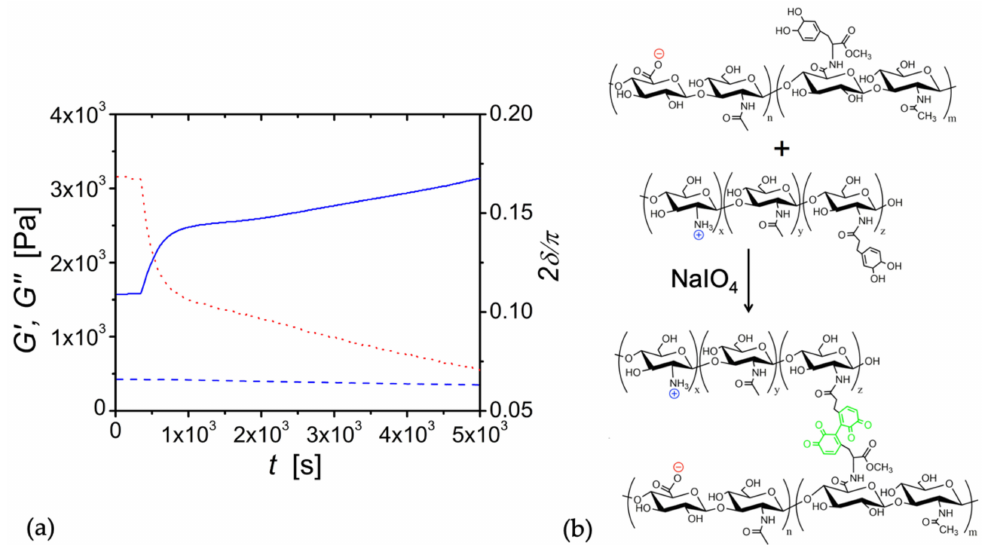
Figure 7. ( a ) Time sweep of CHI (F A : 0.42, catechol: 1 mol %)/HA (M w : 750 kDa, catechol: 1 mol %) coacervate, to which 1 mM periodate solution was added at the sample rim after 5 min. Frequency = 10 Hz. Strain = 2%. The blue solid line represents G (cid:48) , while the blue dashed line denotes G (cid:48)(cid:48) . The red dotted line represents 2 δ / π . ( b ) Schematics of chemical